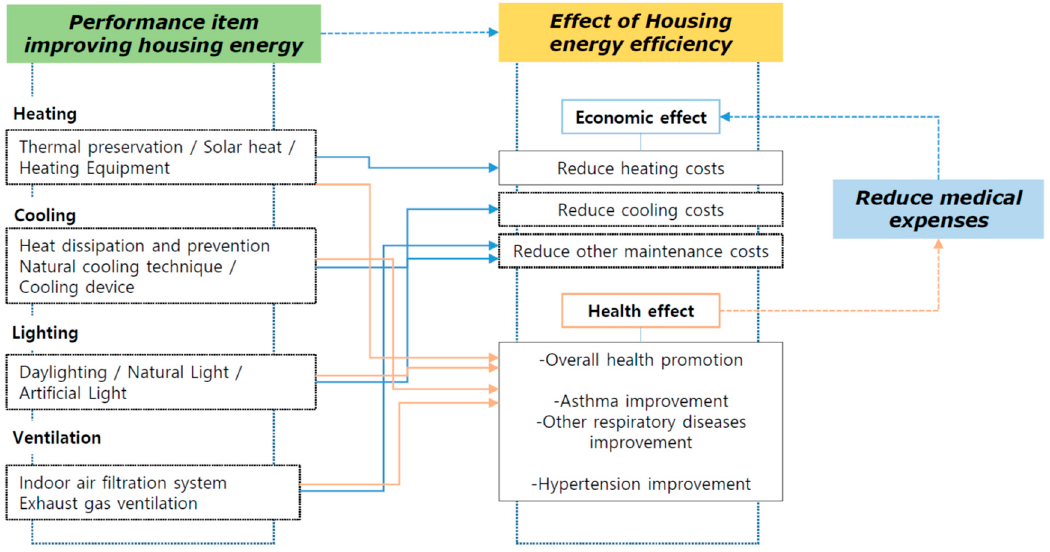
Figure 1. Correlation of energy performance items and the effect of housing energy efficiency.